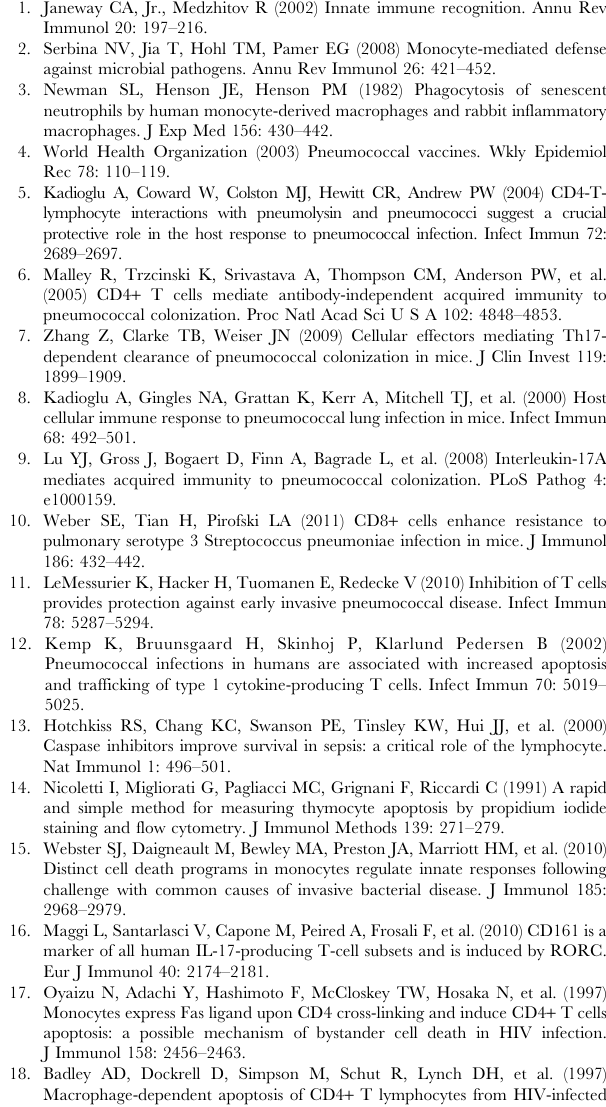
Figure S8 Granzyme B does not induce lymphocyte